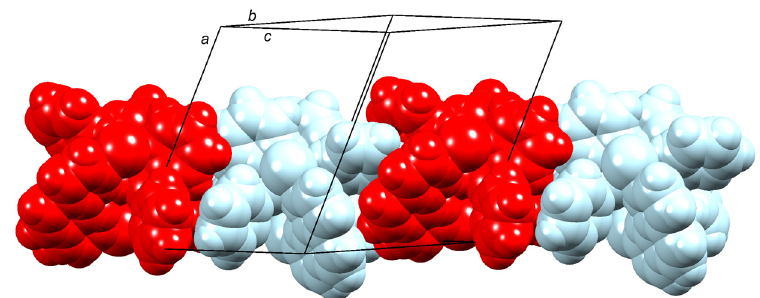
Figure 6. Packing of independent cations (red and pale blue) into chains in [Cu(POP)(2,9-Br 2 phen)][PF 6 ] · 0.5Et 2 O shown in space-filling representation. Anions and solvent molecules are omitted.